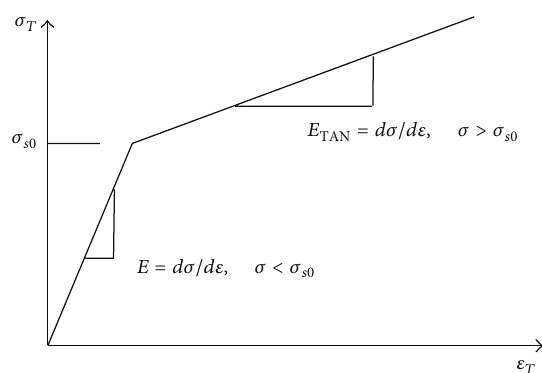
Figure 3: Bilinear isotropic hardening material model.